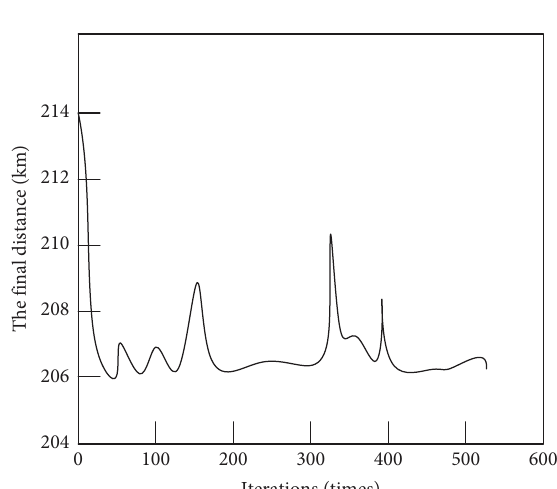
Figure 3: Optimization of the steering angle.